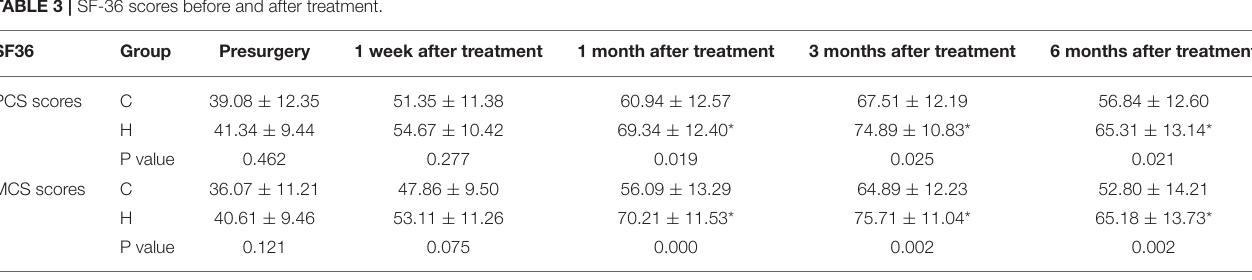
TABLE 3 | SF-36 scores before and after treatment.